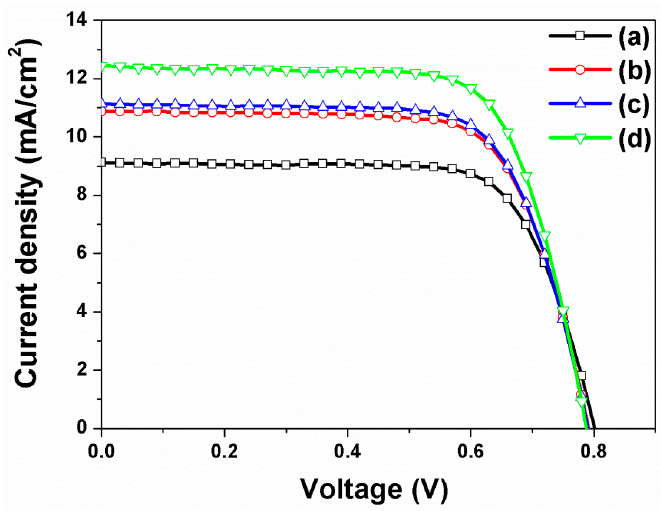
Figure 5. I - V curves of DSSCs based on open-ended freestanding TiO 2 nanotube arrays: ( a ) Without carbon materials and large TiO 2 NPs; ( b ) With carbon materials; ( c ) With large TiO 2 NPs; and ( d ) With carbon materials and large TiO 2 NPs. Table 2. Photovoltaic properties of DSSCs based on open-ended freestanding TiO 2 nanotube arrays with/without carbon materials and with/without large TiO 2 NPs.